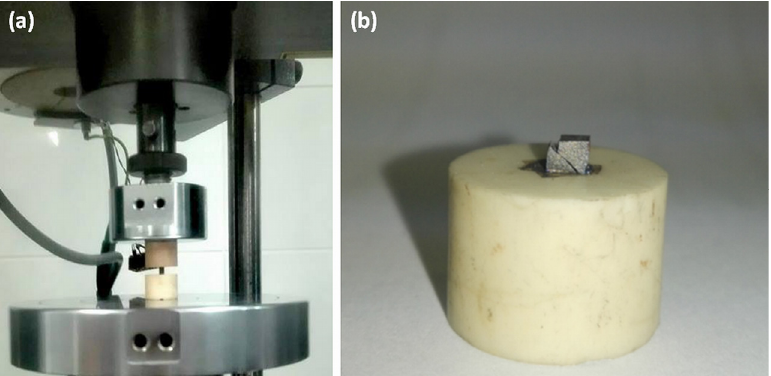
Figure 3. Compressive strength test: ( a ) test node during loading; ( b ) CoCrMo alloy sample from DMLS after the compression test.